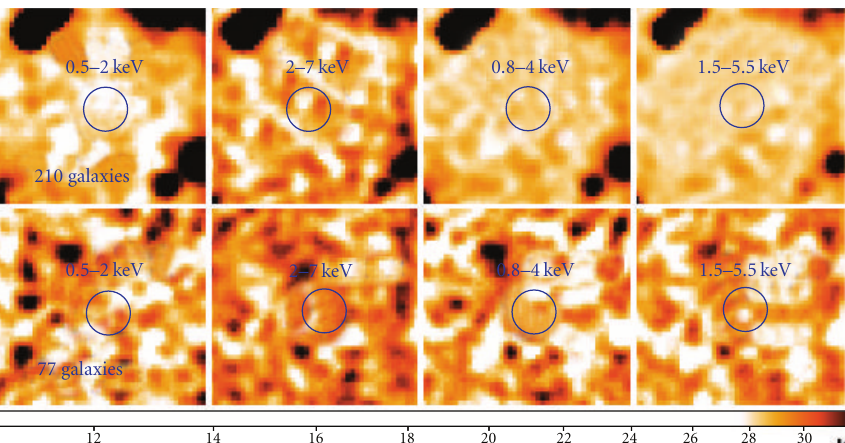
Figure 1: Stacks of Chandra images at the position of 210 and 77 Bouwens et al. [19] candidate z ∼ 6-7 galaxies in four energy bands: 0.5–2 keV, 2–7 keV, 0.8–4 keV, and 1.5–5.5 keV.